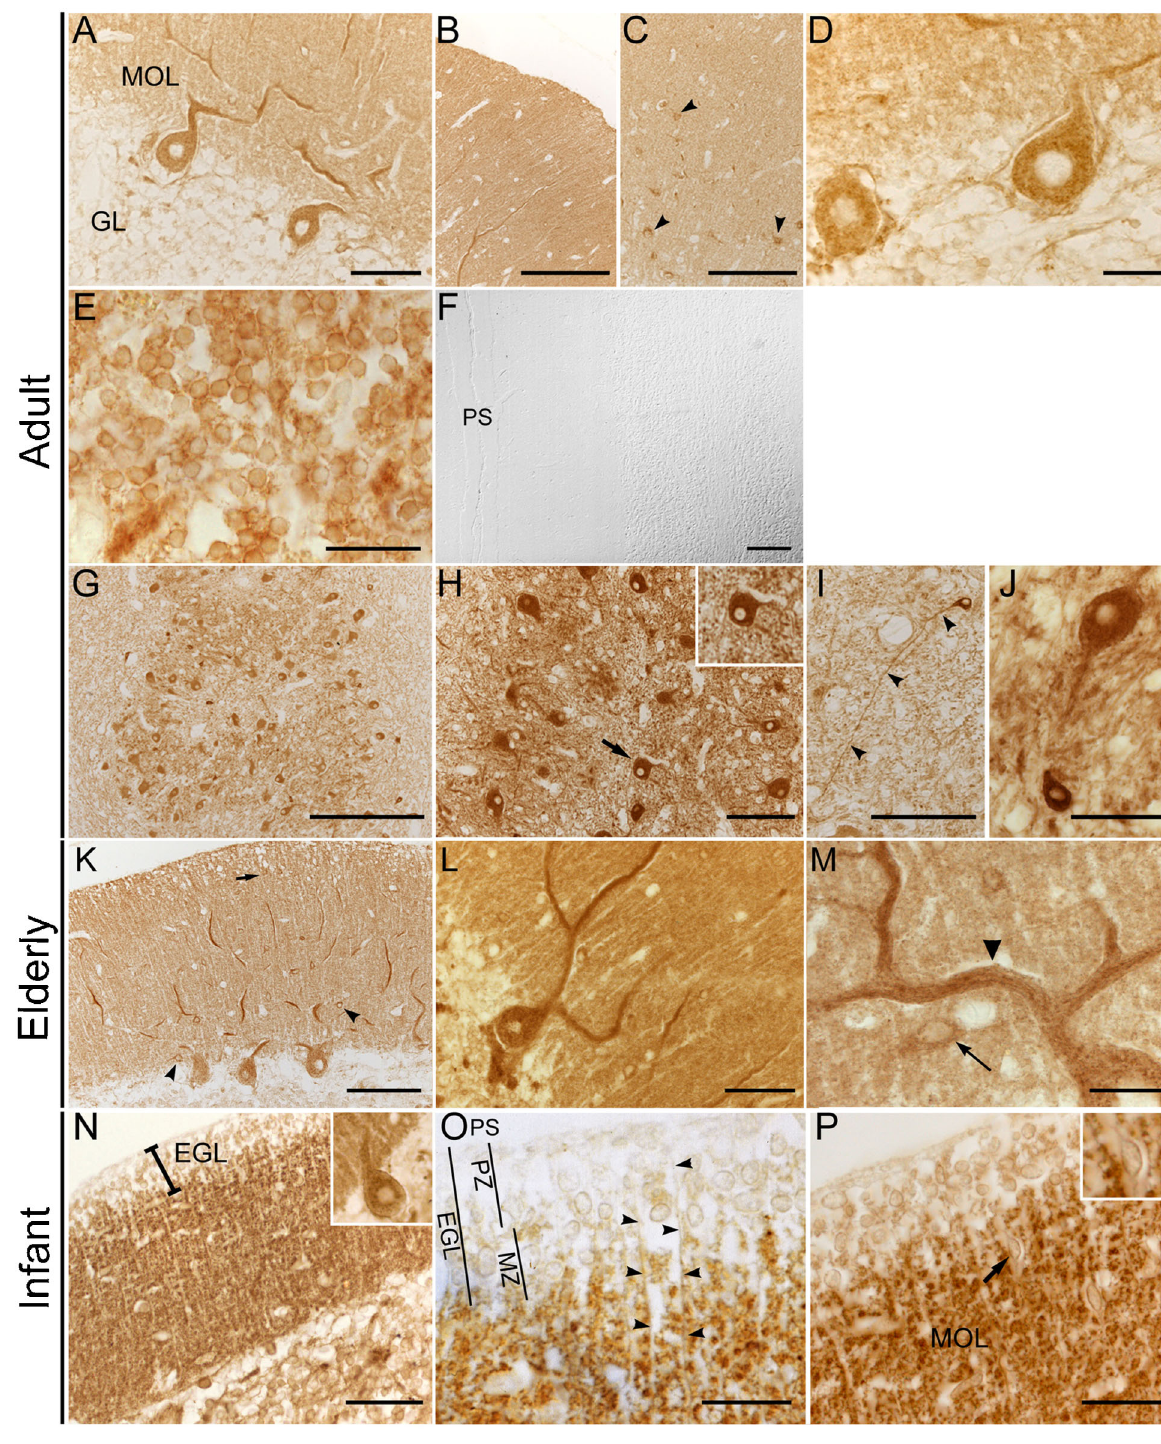
Figure 2. See legend on next